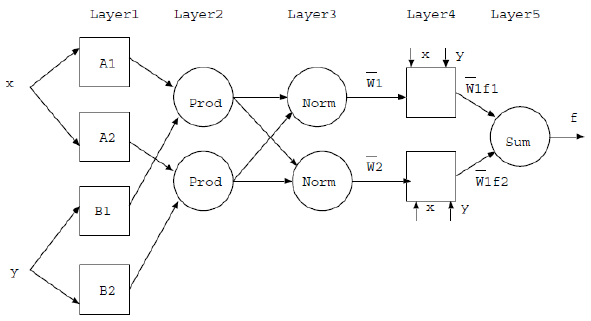
Figure 4. Adaptive neuro-fuzzy inference system (ANFIS) structure (after [32]).